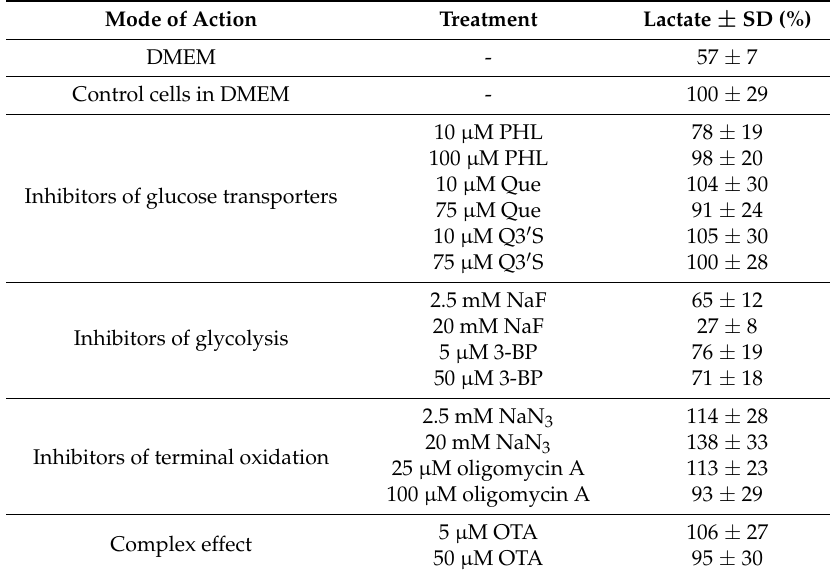
Table 3. Extracellular lactate levels in culture medium after various treatments of HepG2 cells (T = 4 h). Mode of